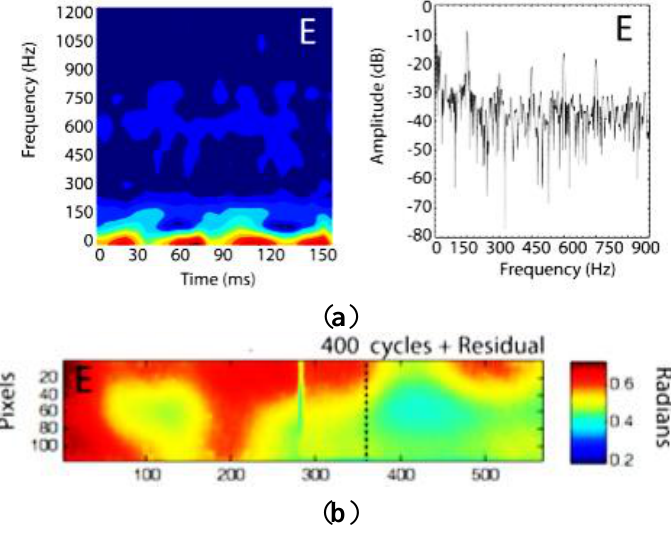
Figure 15. ( a ) STFT (left) and FFT (right) computed from the FBG peak wavelength estimation during fatigue tests; ( b ) corresponding pulsed-phase thermography phase angle image